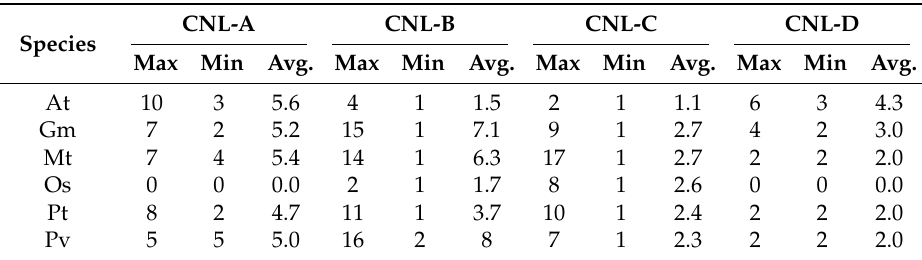
Table 3. Intron-exon structure of the identified nTNL genes in six plant species ( Arabidopsis , soybean, Medicago , rice, common bean and poplar). Max = maximum number of exons, Min = minimum number of exons and Avg. = average number of exons.